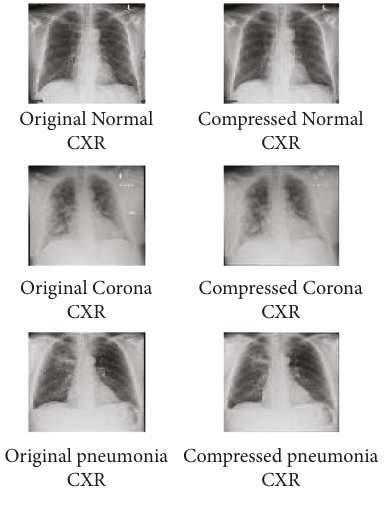
Figure 1: Original and compressed CXR Table 1: PEEN for compressed CXR images.